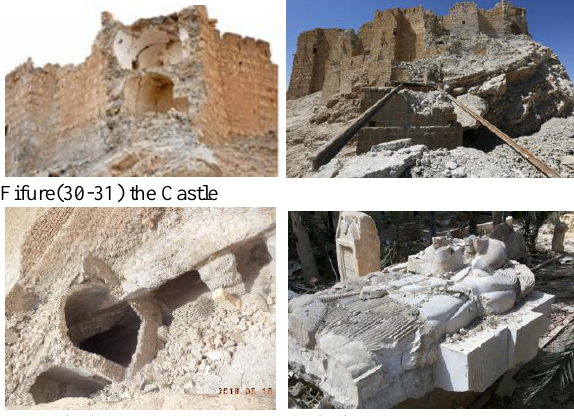
Figure(32) the Aqfa spring Figure(33) Asad Alaat 3- Consevation Management Context: